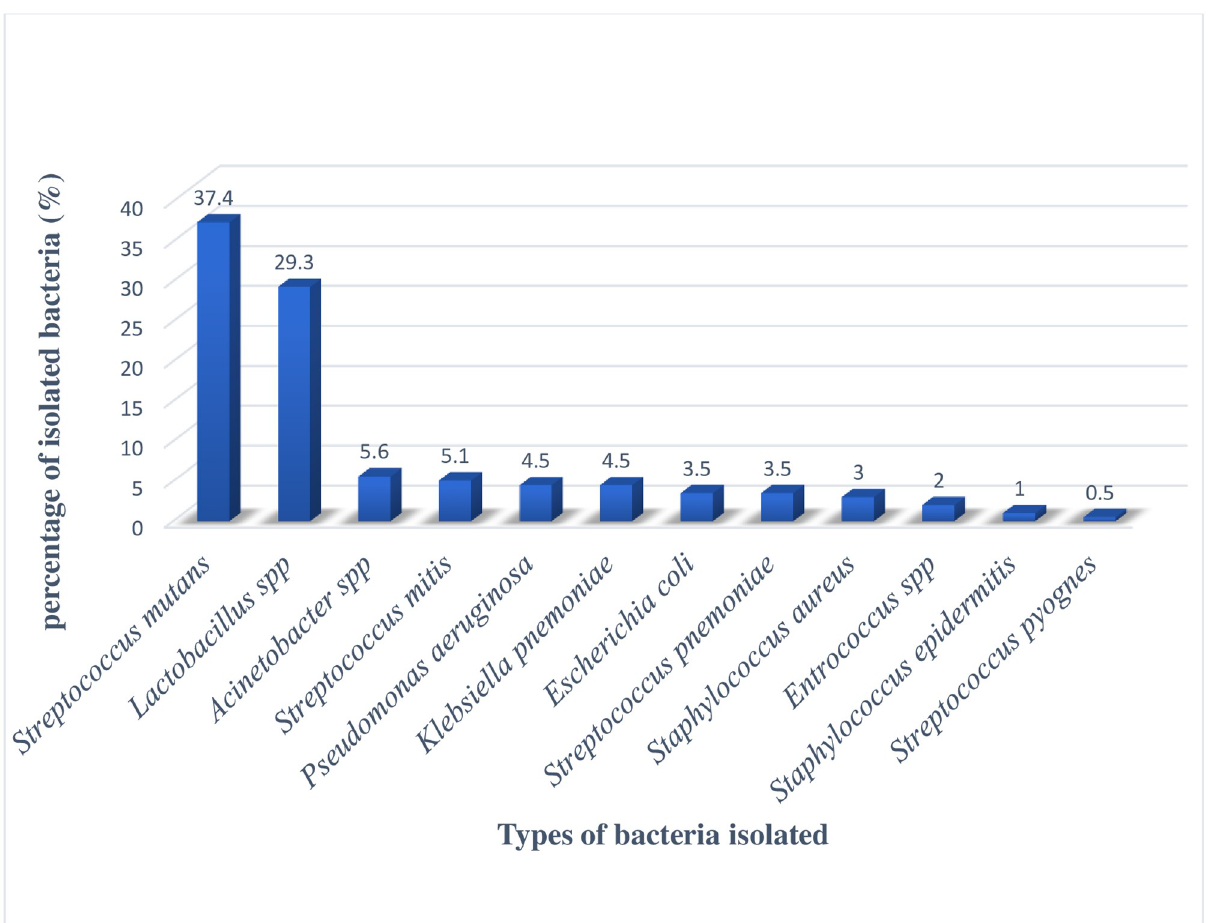
Fig 1. Distribution of isolated bacteria from dental caries patients attended at Hiwot Fana